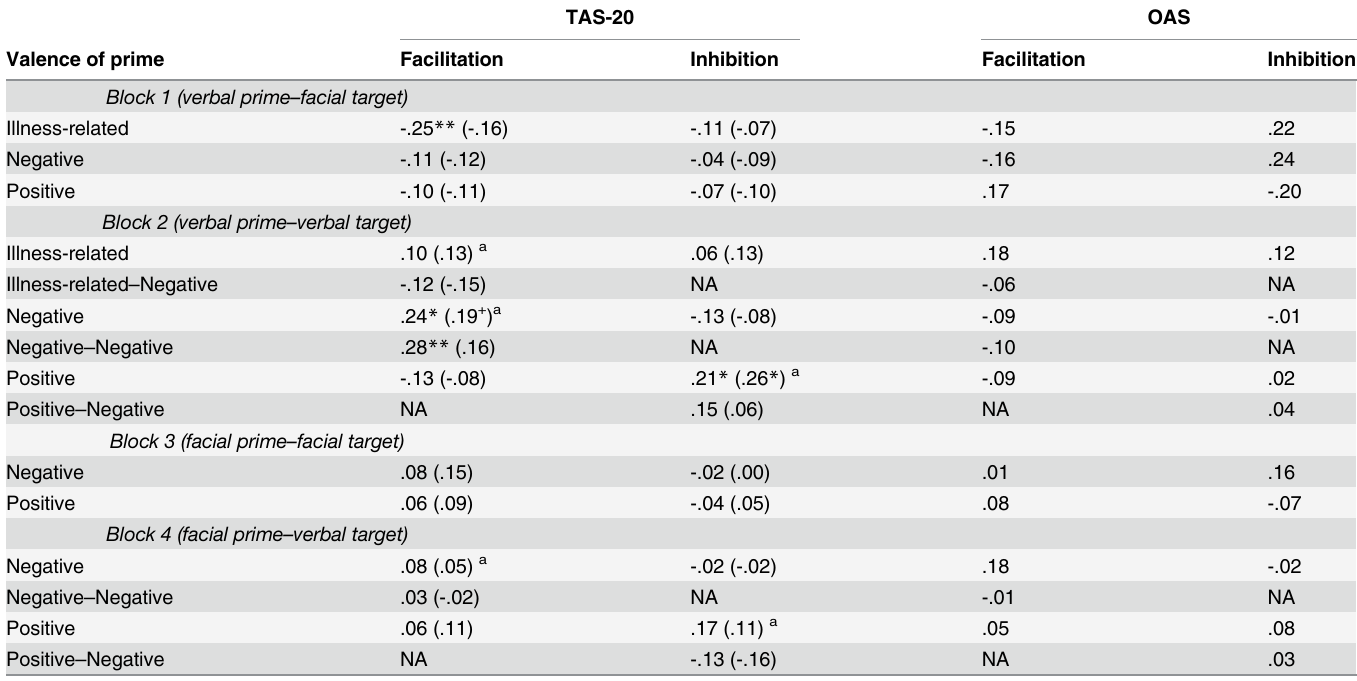
Table 2. Correlations of TAS-20 and OAS Scores with Facilitation and Inhibition